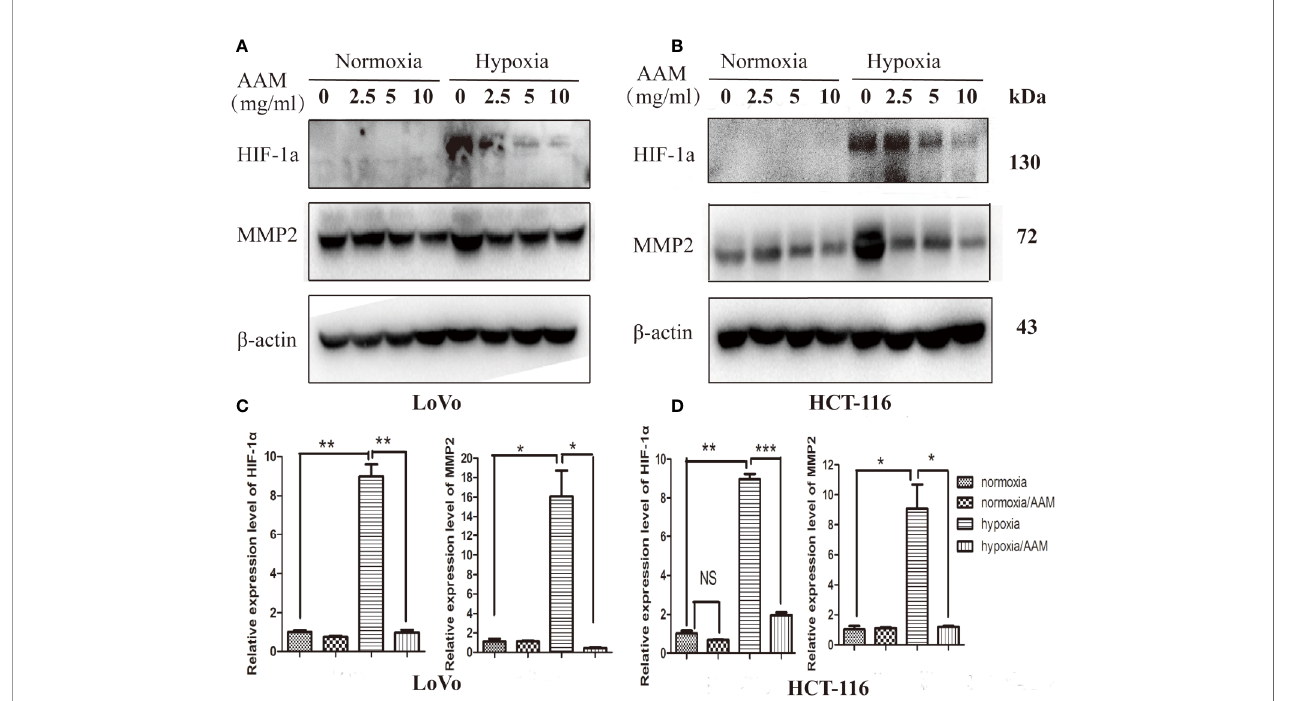
FIGURE 10 | AAM inhibits hypoxia-induced VM formation involving HIF-1 a and MMP2. The HCT-116 (A) and LoVo (B) cells were treated with different concentrations of AAM under hypoxia and normoxia; the protein expression of HIF-1 a and MMP2 was detected by western blotting. (C, D) The mRNA expression of